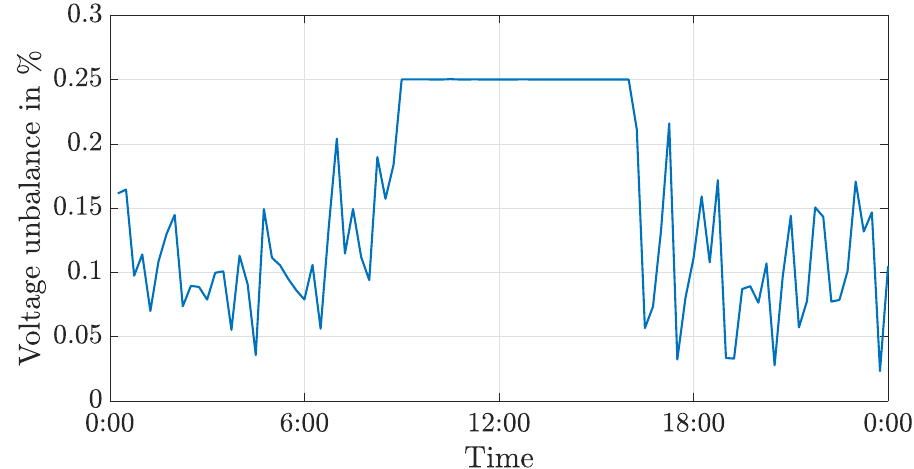
Figure 17. Voltage unbalance at the end of the feeder.